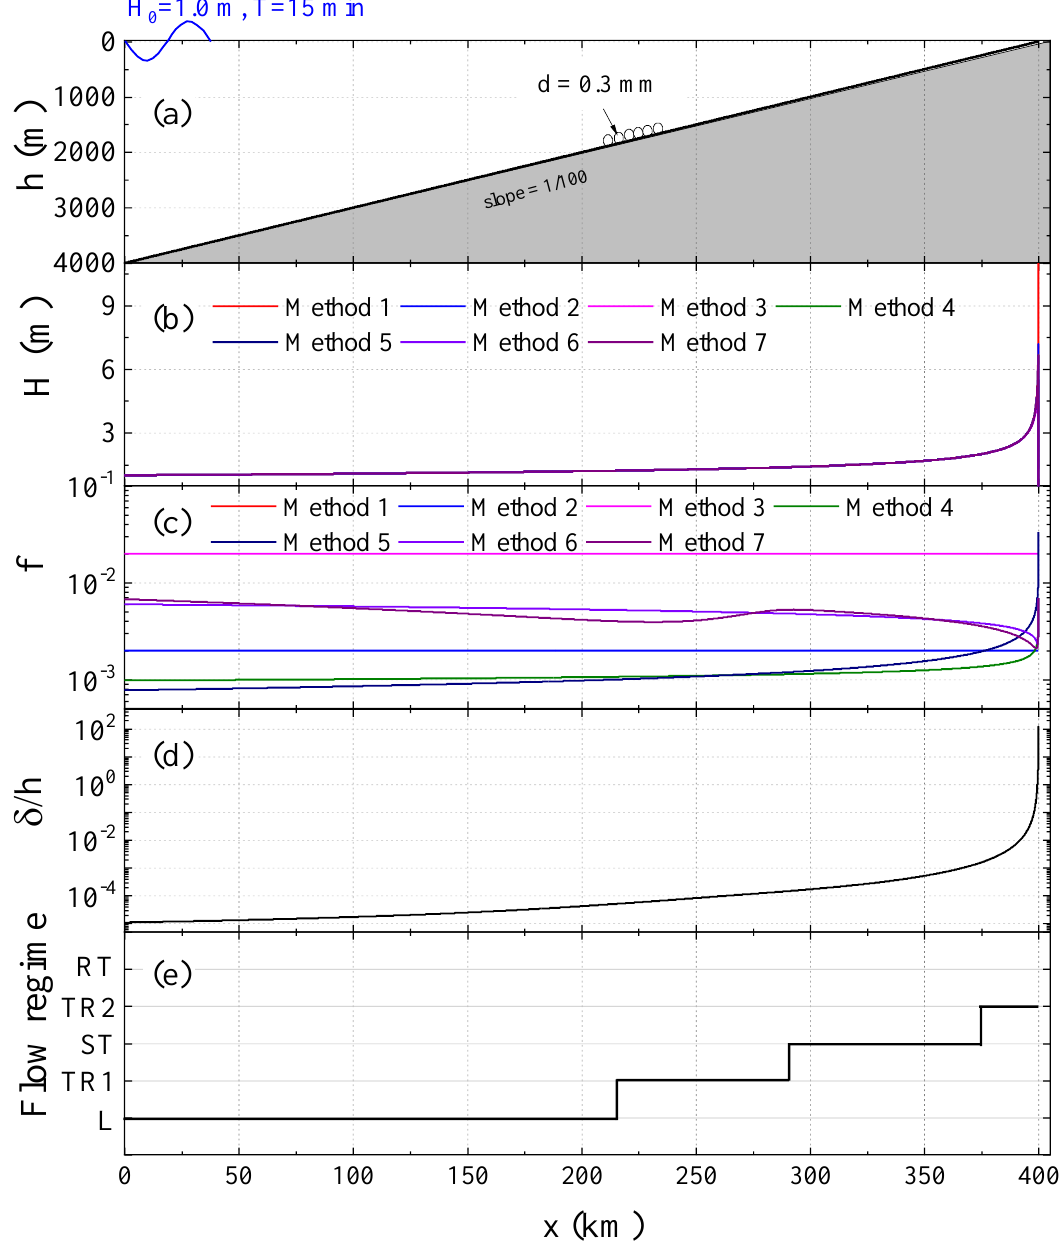
Figure 3. Computation results (in the whole computational domain): ( a ) Bathymetry. ( b ) Wave height. ( c ) Friction coefficient. ( d ) Dimensionless boundary layer thickness. ( e ) Flow regime.